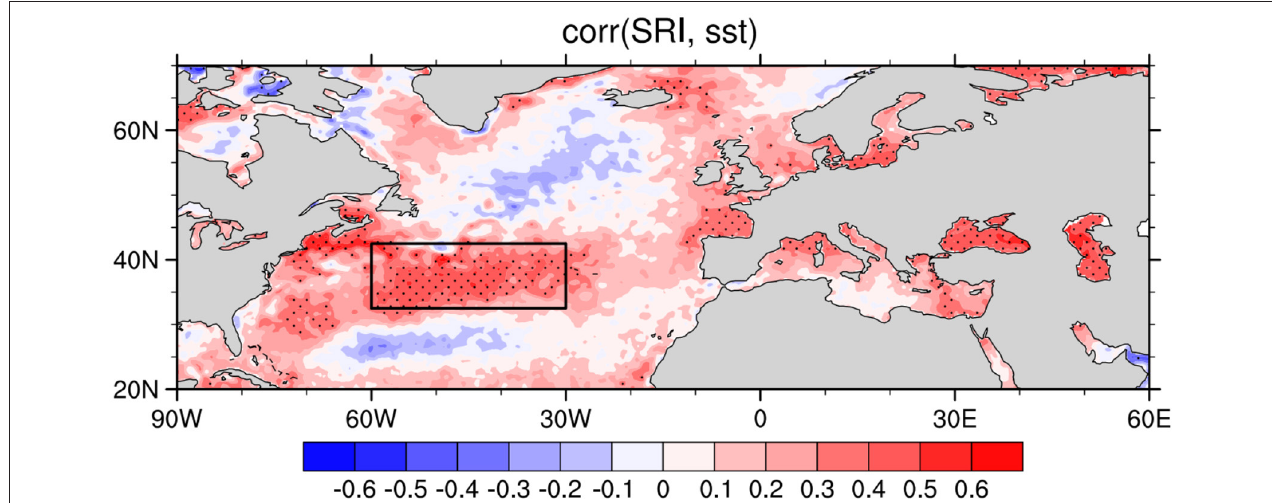
FIGURE 10 | The distribution of correlation coefficients between SSTA (July 1st-July 15th averaged) and SRIs (July 18th-August 5th averaged) (the dots are significant regions at 95% confidence level and the rectangle denotes the chosen key SST region).